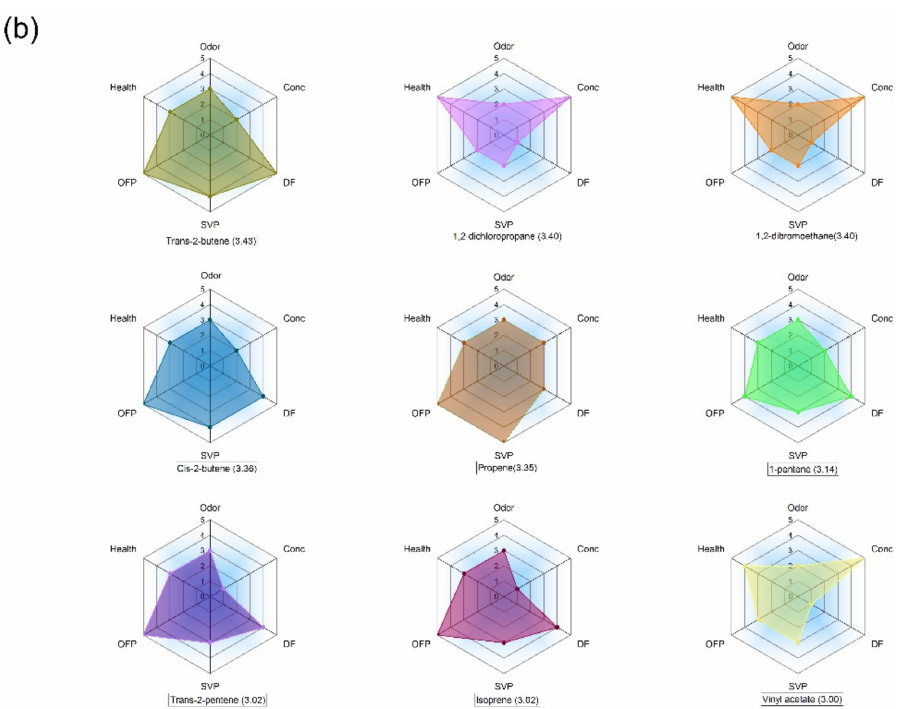
Figure 4. Comprehensive scores of VOCs ( a ) Tier 1 ( b ) Tier 2. (SVP, Conc and DF were the abbreviation of saturated vapor pressure, VOCs concentration, and detection frequency,